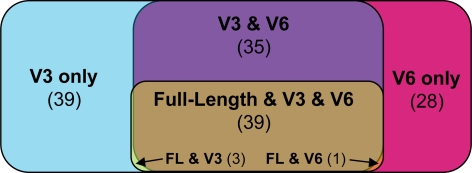
Correspondence of genera found by each method.The Venn Diagram shows the extent of overlap between the V3, V6 and full-length sequencing of the human gut microbiome. The V3 tag sequencing found the most genera (116), the V6 found 103 genera, and full-length sequencing found only 43 genera.